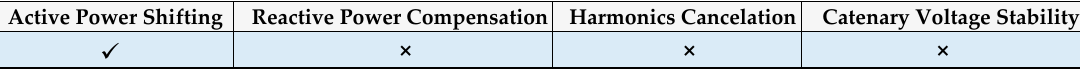
Figure 5. RPC operating as an interface converter between two substations (based on [42]). Table 3. Capabilities of the RPC operating as an interface converter between two substations.